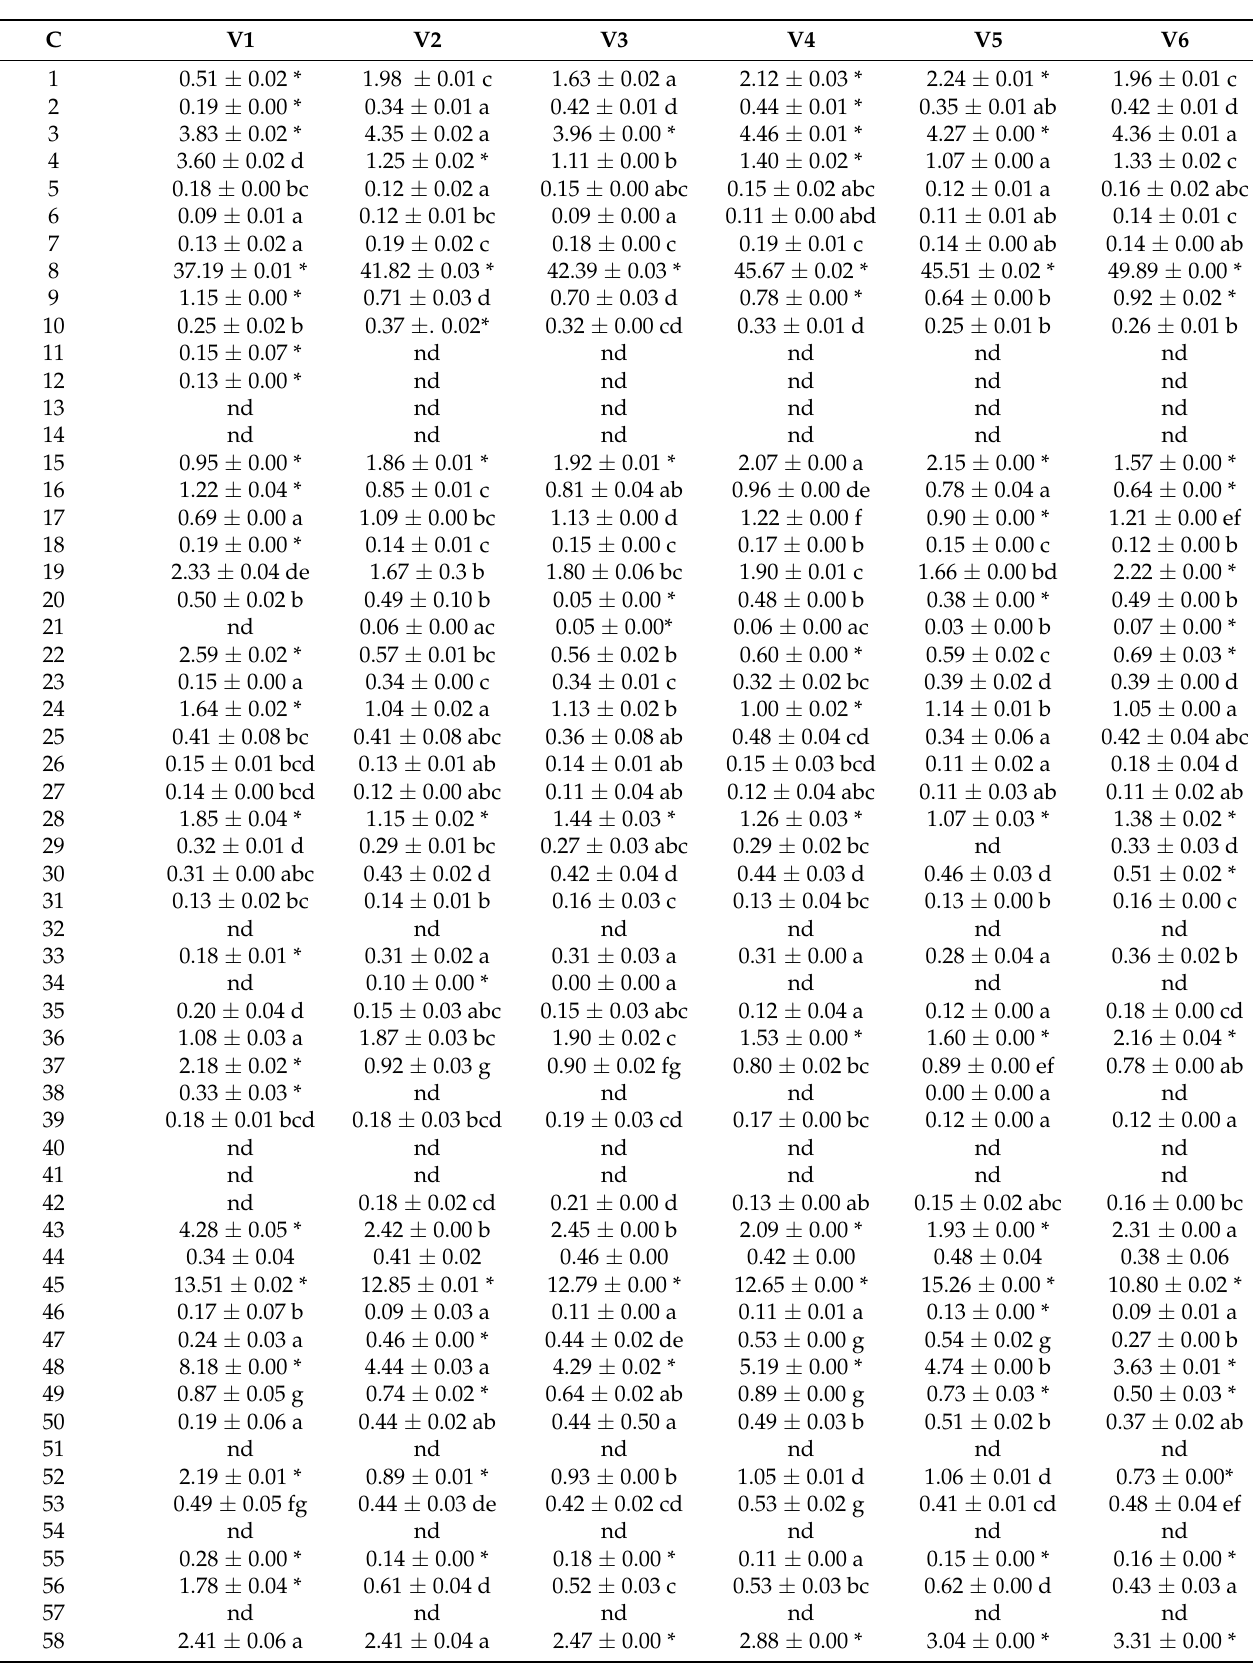
Table 2. Final proportion of identified volatile compounds in Feteasc ă regal ă wines (% of total